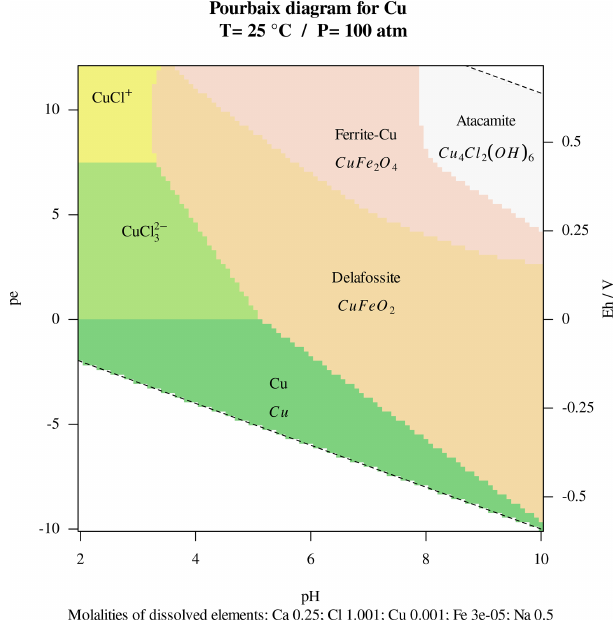
Figure 2. Pourbaix diagrams of copper across aqueous and solid species, using the llnl.dat thermodynamical database. Since at each point of the diagram all equilibrium activities are considered, the boundaries between predominance regions are no longer straight lines but curves. The interpretation of these diagrams requires ex- pert knowledge. For example, kinetic limitation would prevent pre- cipitation of delafossite from aqueous phase at 25 ◦ C (John et al.,